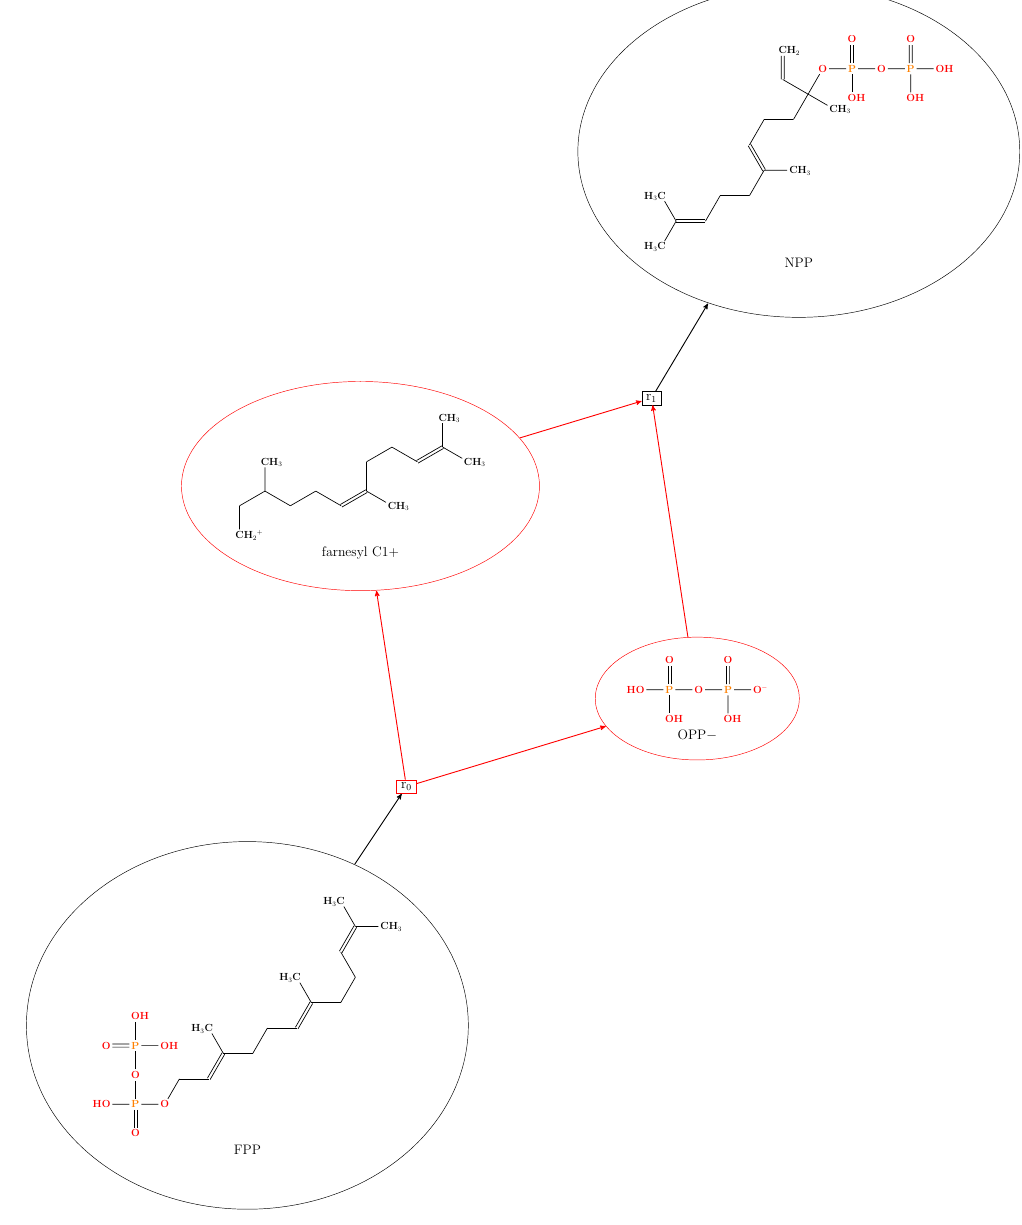
Figure 1. The plotted result of Simulation 01 for OPP (Diphosphate) cleavage from FPP (Farnesyl